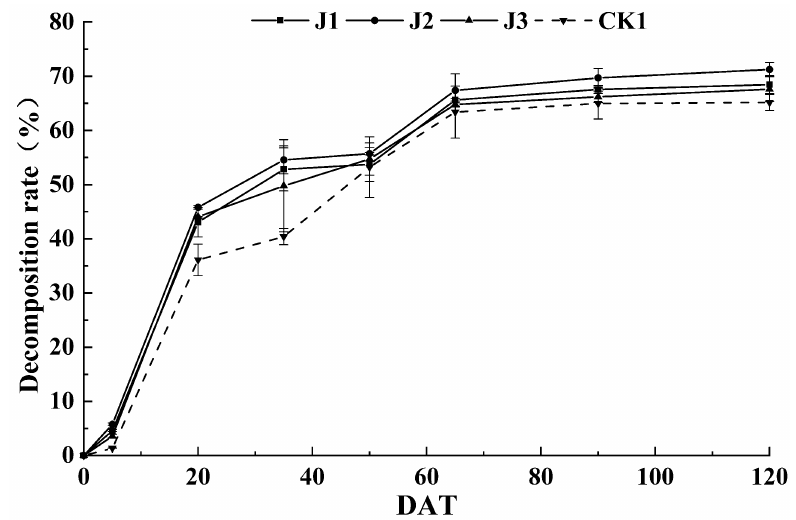
Figure 1. The decomposition rate of straw under the applied fertilization methods. The error bars show the standard error ( n = 3).